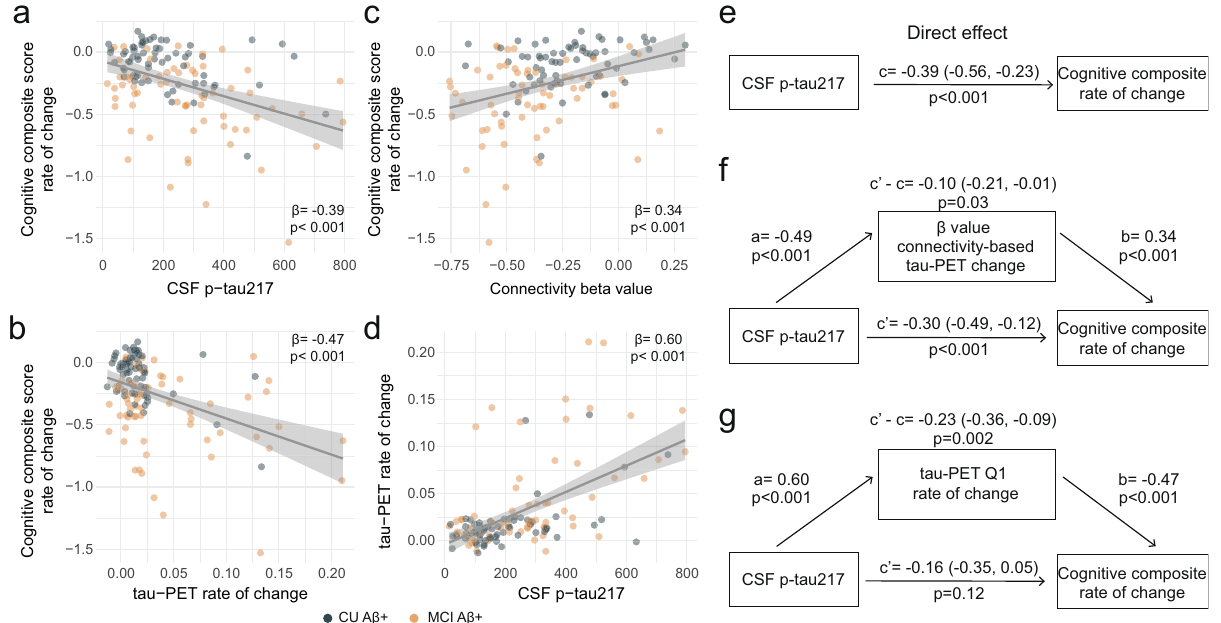
Fig. 4 | Tau aggregates accumulation mediates associations between CSF p-tau217 and cognitive decline in A β -positive non-demented participants. a – d Scatter plots of associations relevant to subsequent mediation analyses, beta coef fi cients from linear regressions adjusting for age, sex and education are reported. a Association between CSF p-tau217 and rate of change on the cognitive composite score. b Association between tau-PET rate of change in Q1 and rate of change on the cognitive composite score. c Association between β -value from the correlation between tau-PET rate of change and connectivity-based distance to epicenters across all brain regions and rate of change on the cognitive composite score. d Association between CSF p-tau217 and tau-PET rate of change in Q1. e – g Mediation analysis of the relationship between CSF p-tau217, measures of tau-PET and cognitive decline measured as the rate of change on the cognitive composite score. The direct effect ( c ) of CSF p-tau217 on cognitive decline is shown in e .